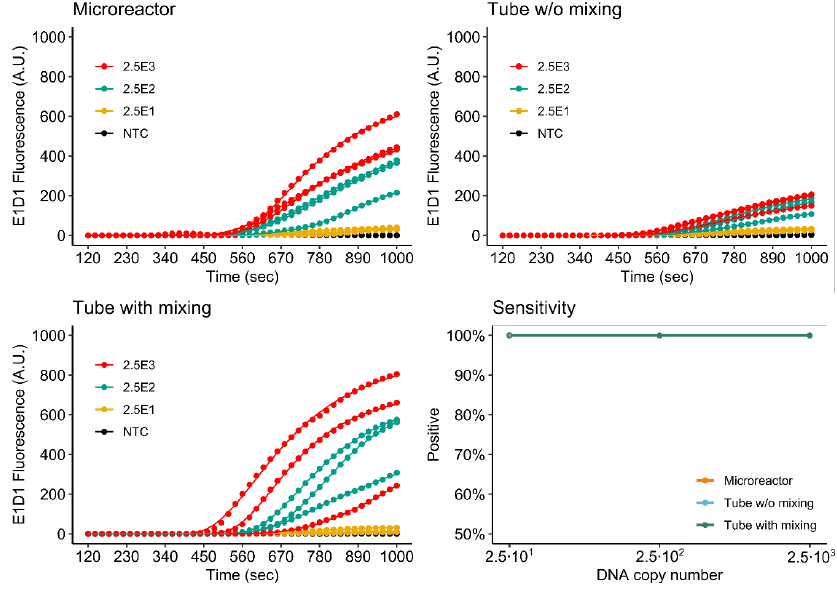
Figure 11. Detection of khe by duplex rtRPA.